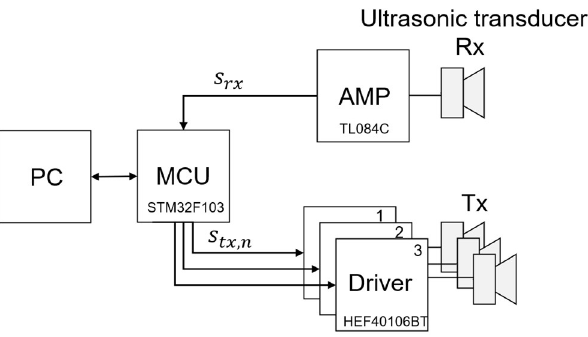
Figure 5. Ultrasonic transceiver system block diagram for proposed algorithm verification.